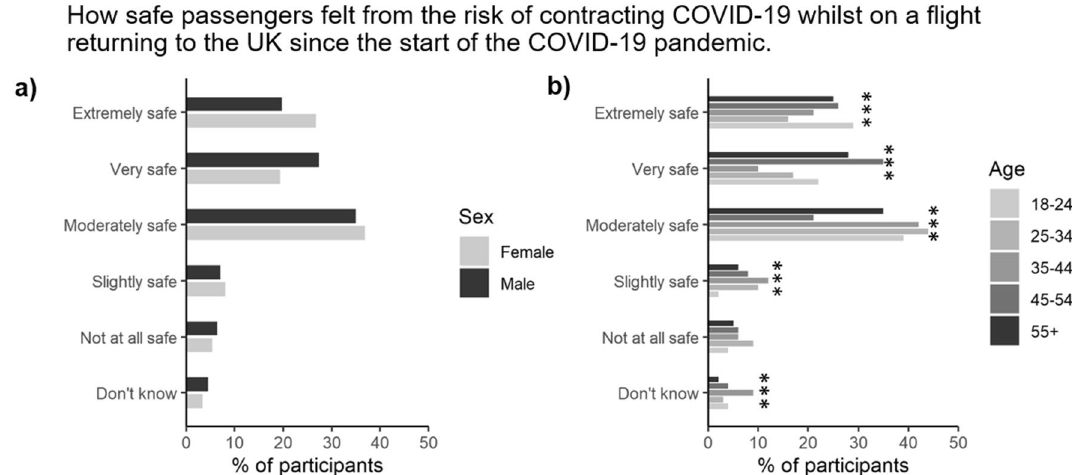
Figure 7. Proportion of participants stratified by either ( a ) gender, or ( b ) age ( n = 305). *, **, and *** represent significant differences between the gender or age categories for a particular symptom at the P < 0.05, P < 0.01 or P < 0.001 level, respectively.